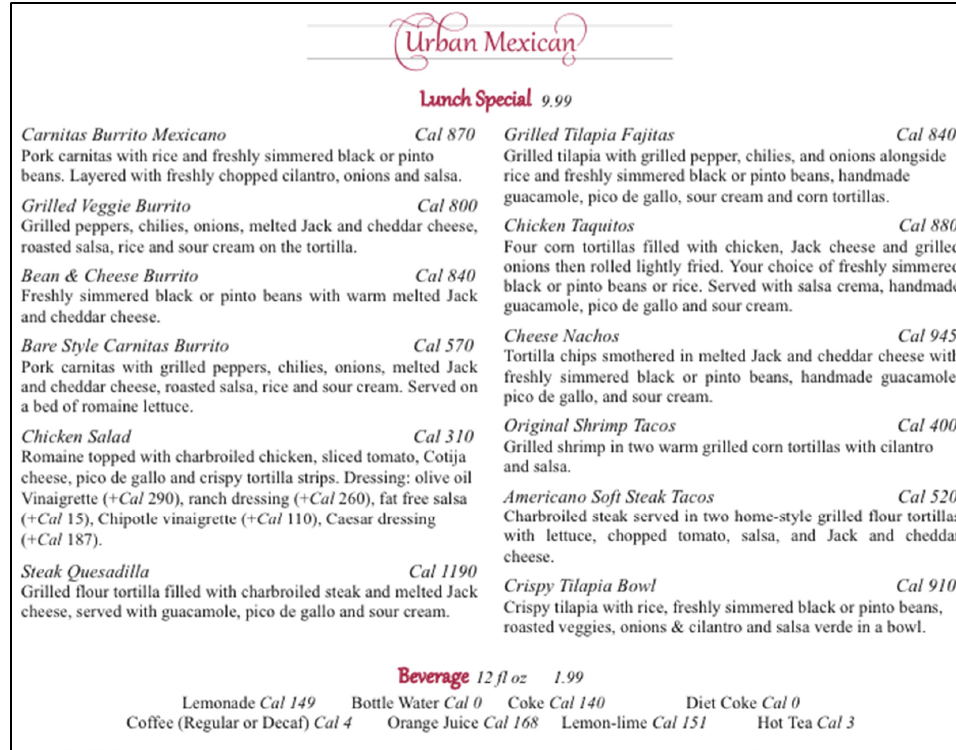
Figure A8. California Cafe Light and Fresh Menu.